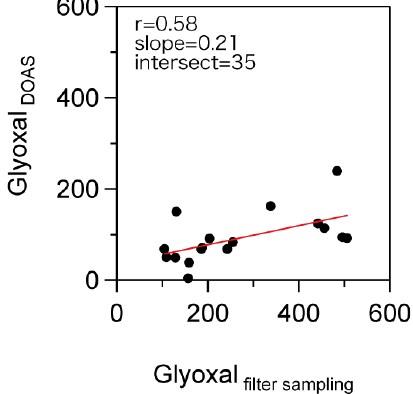
Fig. 8. Relationship between the concentrations (pptv) of glyoxal by MAX-DOAS and filter sampling/GC